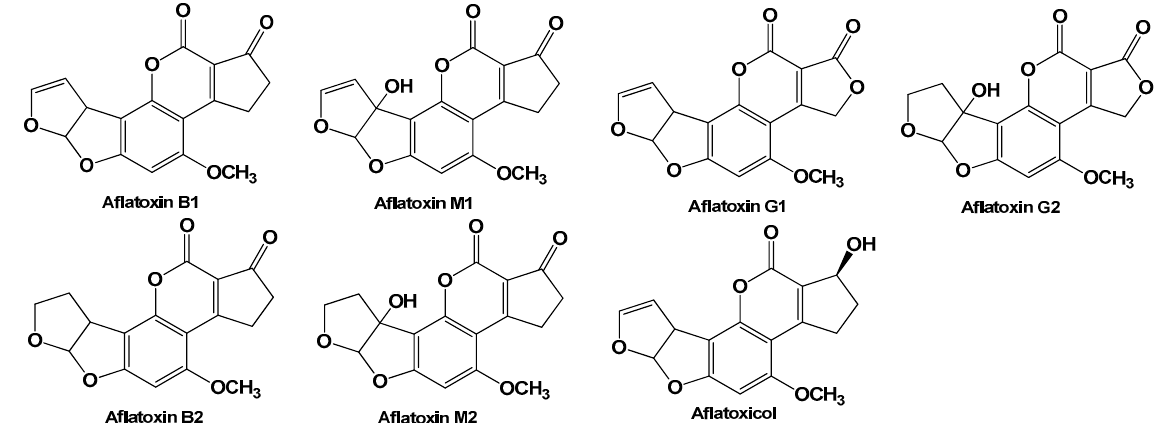
Figure 1. Chemical structure of aflatoxins.